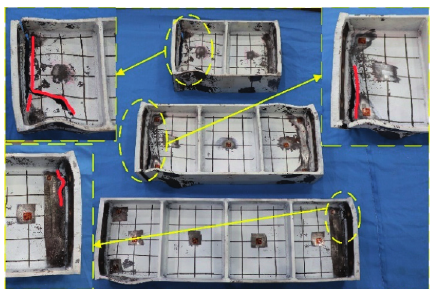
Figure 15: Experimental phenomena of specimen PDKW-1. (a) Deformation at 3 δ (d) Deformation at 8 δ y .